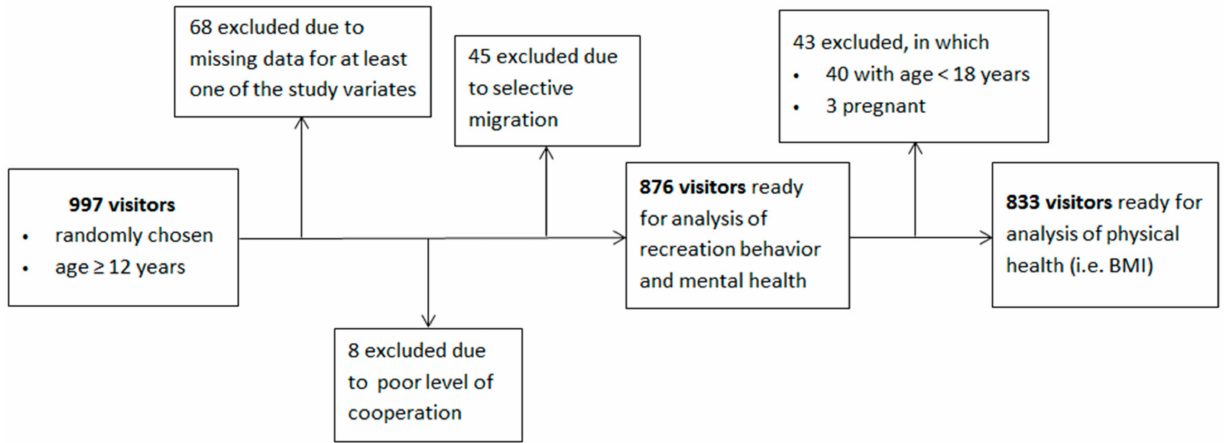
Figure 4. Flowchart of pre-processing of